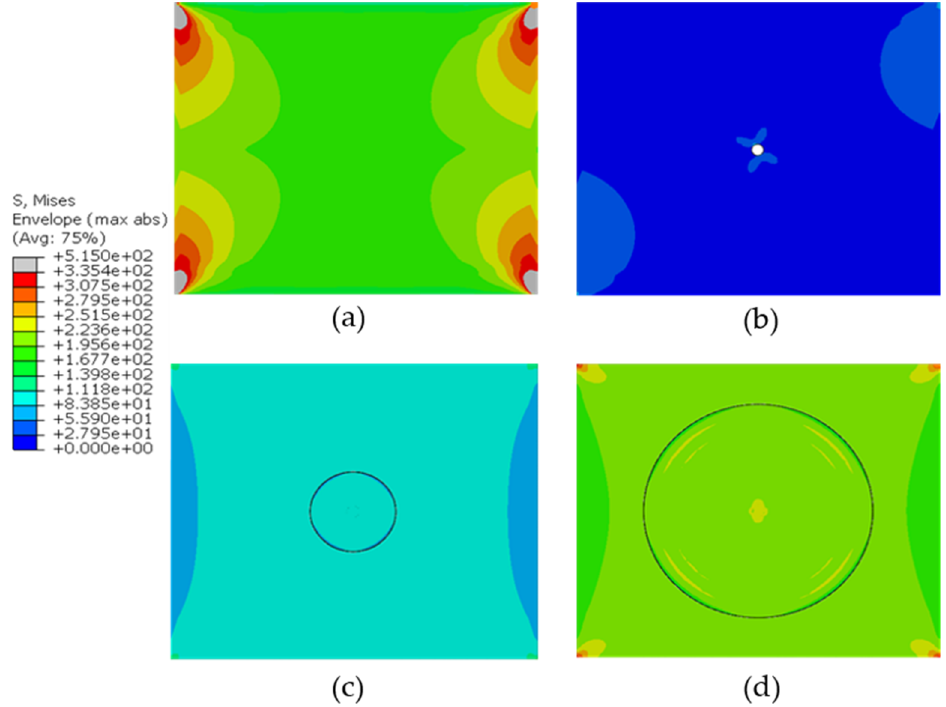
Figure 5. Breakdown using the criterion Von Mises ( a ): pristine plate, ( b ): damaged plate with a 5 mm radius hole, ( c ): repaired plate with ratio scarf 20, ( d ): repaired plate with ratio scarf 60.